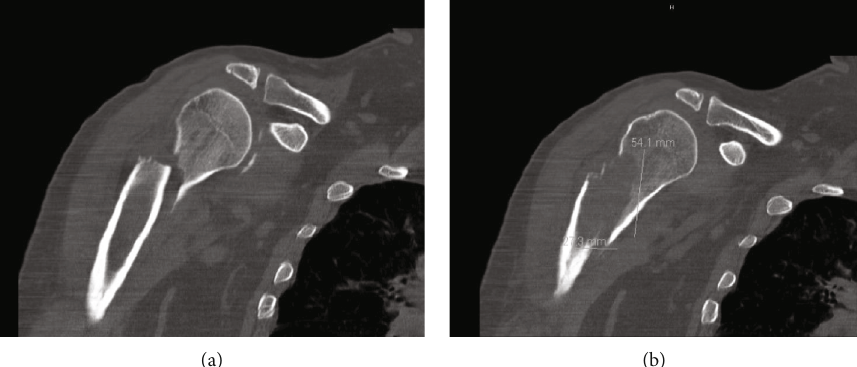
Figure 2: (a) Computerized tomography scan of shoulder showing an oblique comminuted fracture of the proximal diaphysis of humerus. (b) An ovoid lucency measuring approximately 5 : 5 × 2 : 8cm within the proximal humerus shaft at the site of fracture.